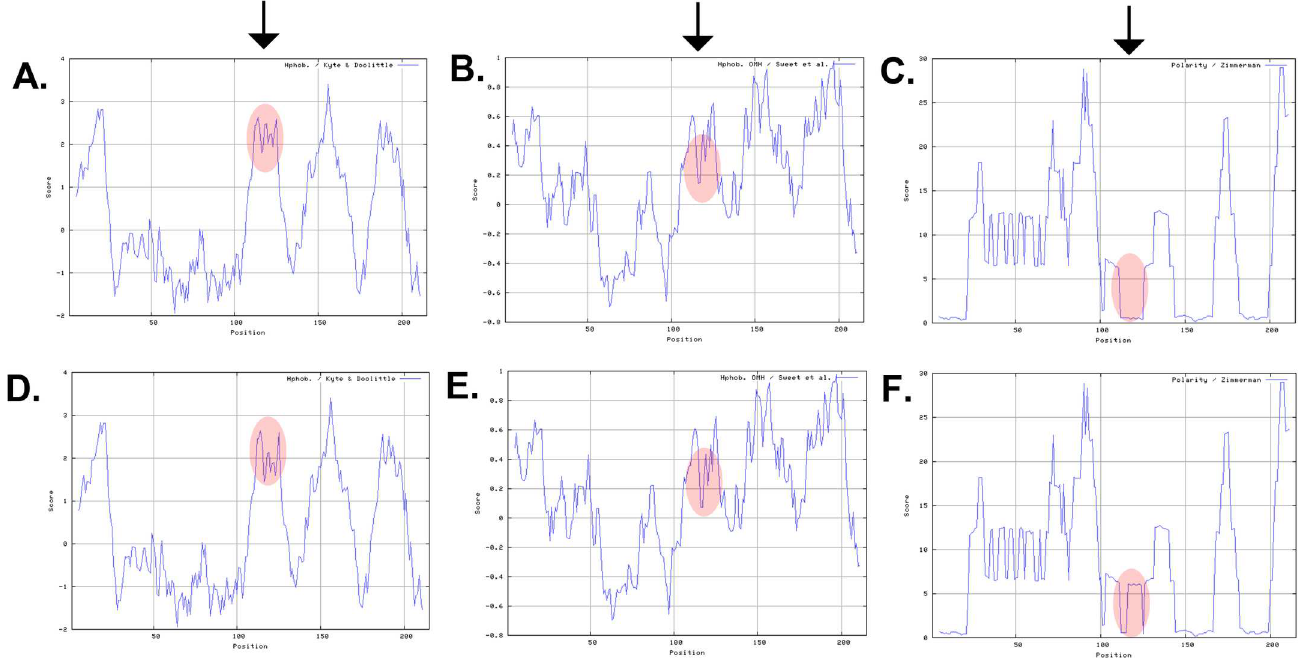
Fig 4. Investigating the physical characteristics of wild-type and mutant MP19. Mutant MP19 (p.G78D) exhibitedlower hydropathicity (compare A with D ), lower hydrophobicity (compare B with E ), and higher polarity (compare C with F ). The x-axis represents the position of the amino acids while the y-axis represents the hydropathicity, hydrophobicity, and polarity values in a default window size of 9. Arrows point to the difference in their respective hydropathicity (1 st arrow), hydrophobicity (2 nd arrow), and polarity (3 rd arrow).